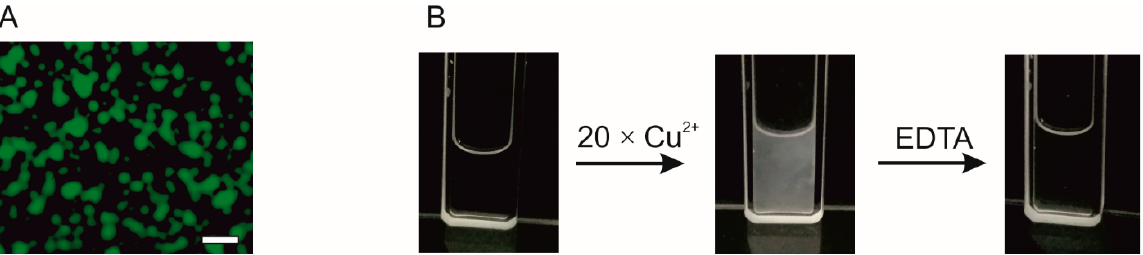
Figure 6. AaFEcR domain containing condensates exhibit liquid properties. ( A ) shows condensates formed by 70 µ M fluorescently labeled F domain in 10 mM Tris-HCl, 150 mM NaCl, and pH 7.5 buffer supplemented with 20 × molar excess of Cu 2+ ions. The condensates wet the glass slide. ( B ) The changes of the F domain solution turbidity caused by the addition of 20 × molar excess of Cu 2+ ions and EDTA. Scale bar 5 µ